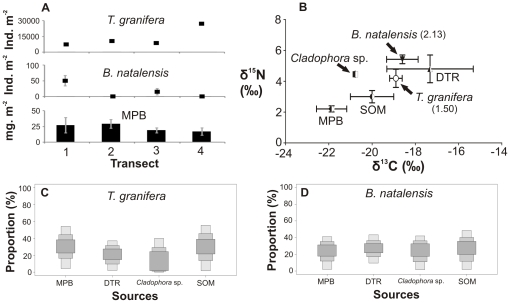
Gastropods, food types and diets in Lake Sibaya, 2009.(A) Four-point 3 m transect showing gastropod densities and microphytobenthic (MPB) biomass (as chl-a concentration). (B) Carbon and nitrogen stable isotope signatures of gastropods (number in brackets: trophic position) and their potential food sources, such as detritus (DTR) and sedimentary organic matter (SOM). SIAR boxplots show the proportional contribution (%) of different sources to the diet of (C) Tarebia granifera and (D) Bulinus natalensis. Samples were collected in November 2009. This lake has no connection to the sea and contains pure freshwater.